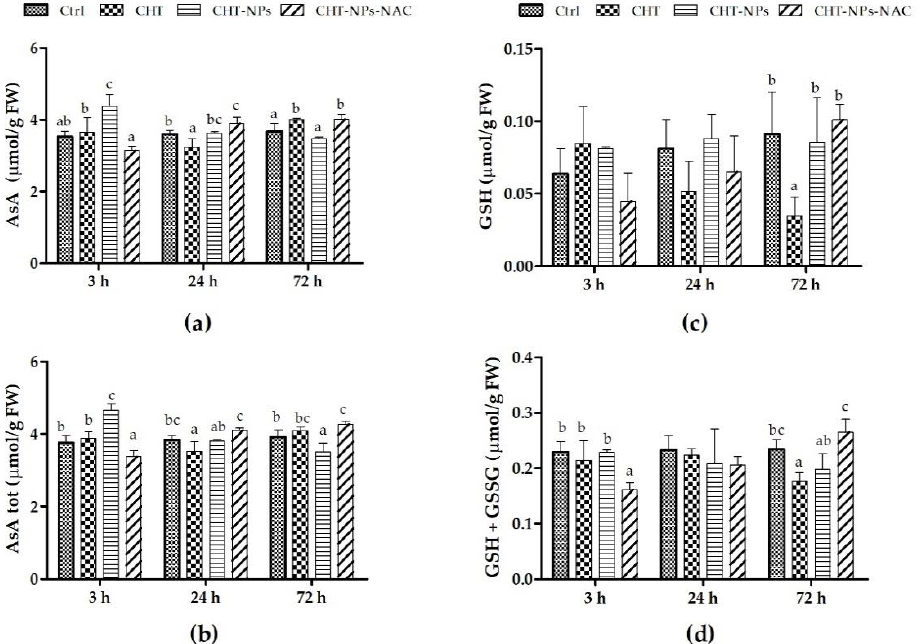
Figure 2. Contents of ( a ) reduced ascorbate (AsA), ( b ) total ascorbate (AsA + DHA), ( c ) reduced glutathione (GSH), and ( d ) total glutathione (GSH + oxidized glutathione (GSSG)) in three-week old seedlings of Triticum durum cv. Fabulis at 3, 24, and 72 h after treatments with water (Ctrl), CHT, CHT-NPs, and CHT-NPs-NAC. Vertical bars indicate SD (n = 3). At each time point, different letters indicate statistically significant differences among treatments, according to a one-way ANOVA followed by Least Significance Difference (LSD) post-hoc test ( p < 0.05).